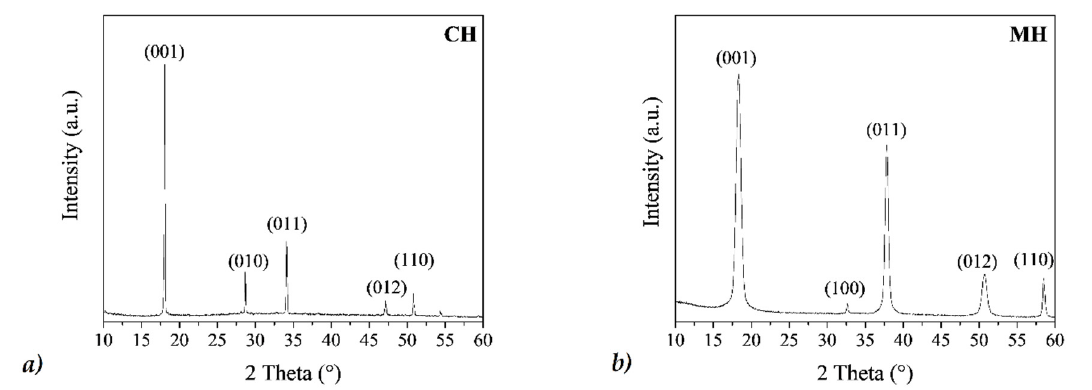
Figure 4. X-ray powder diffraction (XRD) patterns of ( a ) calcium hydroxide (CH), and ( b ) magnesium hydroxide (MH) dry powders. Bragg peaks are indexed by Miller notation.